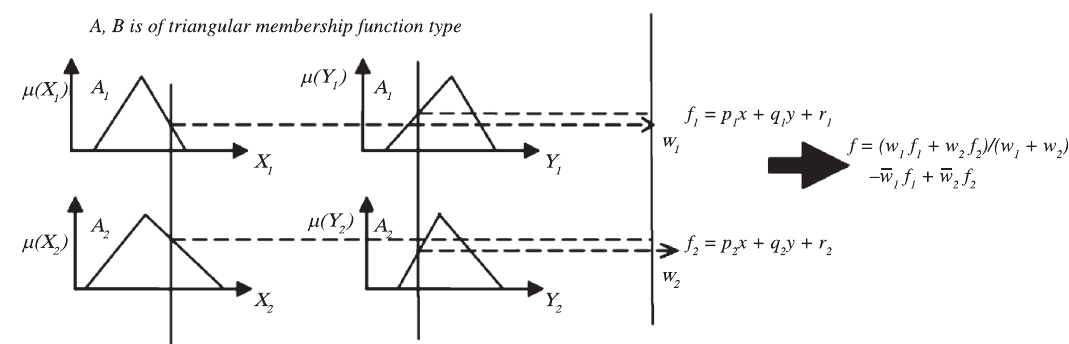
Figure 3. The reasoning sheme of ANFIS 22 .